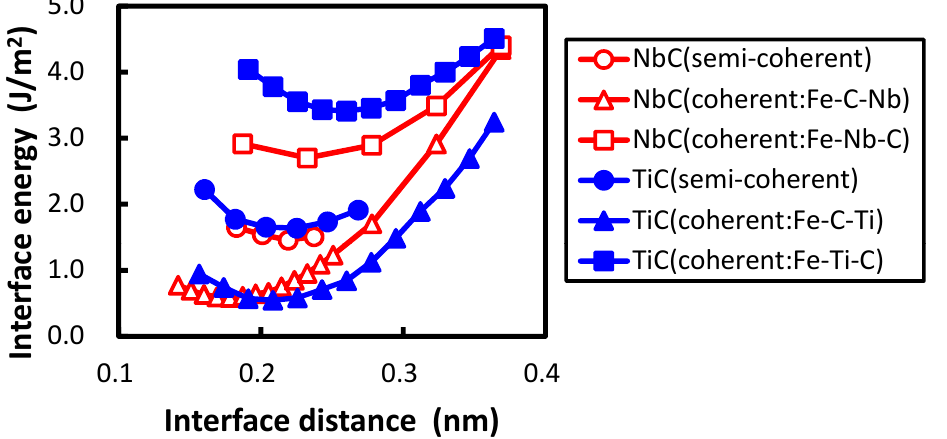
Figure 2. The interface distance dependence on the interface energies of the coherent and semi-coherent interfaces between the TiC and bcc iron and those between the NbC and body-centered cubic (bcc)